Question: Provide a one-line summary of what is displayed.
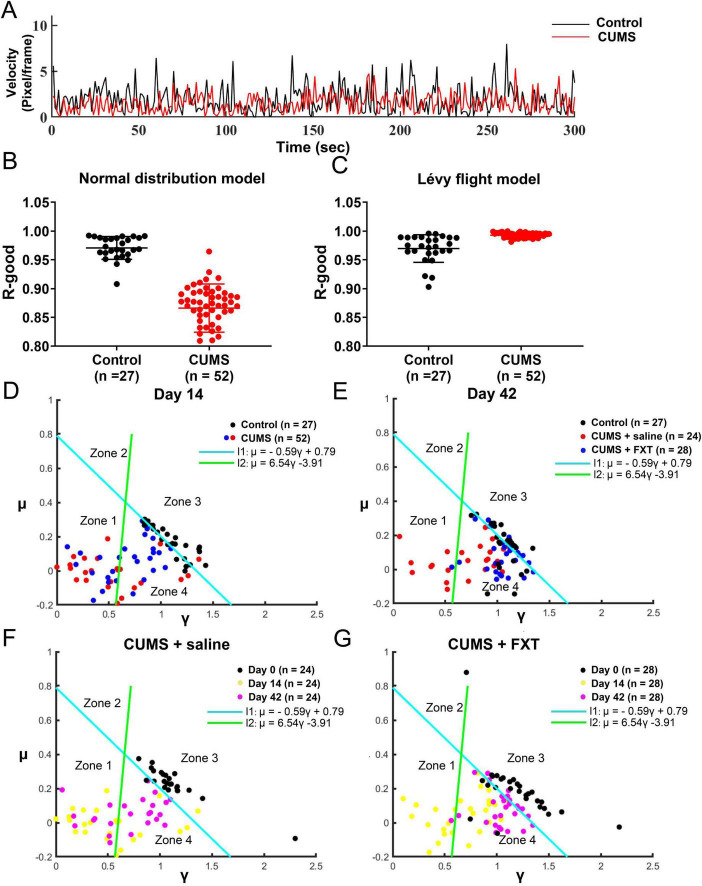
Answer: Validation of the CUMS model in the LF paradigm. (A) A mouse was selected randomly, and the walking speed of the two groups was recorded as a function of time. (B,C) Random selection was performed for a control mouse and a CUMS mouse to apply the control distribution and LF distribution models. (D) The black dots on the γ−−μ plane represented control mice ( n = 27), while red and blue dots represented CUMS mice ( n = 52). Our analysis indicated that LF patterns in the OFT distinguished Control and CUMS mice. The OFT data for the two groups were analyzed at the 14th-day time point after CUMS modeling. A substantial difference between control and CUMS mice was observed on the γ−−μ plane. (E) After day 14, CUMS-stressed mice were divided into CUMS + Saline and CUMS + FXT groups. On day 42, a significant difference between the CUMS + Saline and CUMS + FXT groups was observed. The comparison between Control and CUMS + Saline during OFT indicated a substantial difference, while no significant difference was found between Control and CUMS + FXT groups. (F) The OFT data for the CUMS + Saline group were compared using the same method at 0, 14, and 42 days. (G) Significant differences were observed in pairwise comparisons of OFT data at the three-time points in the CUMS + FXT group. The number of animals is indicated on the graphs. The null hypothesis that the 2D sets of variables followed the same distribution was tested using the two-dimensional Kolmogorov-Smirnov test.